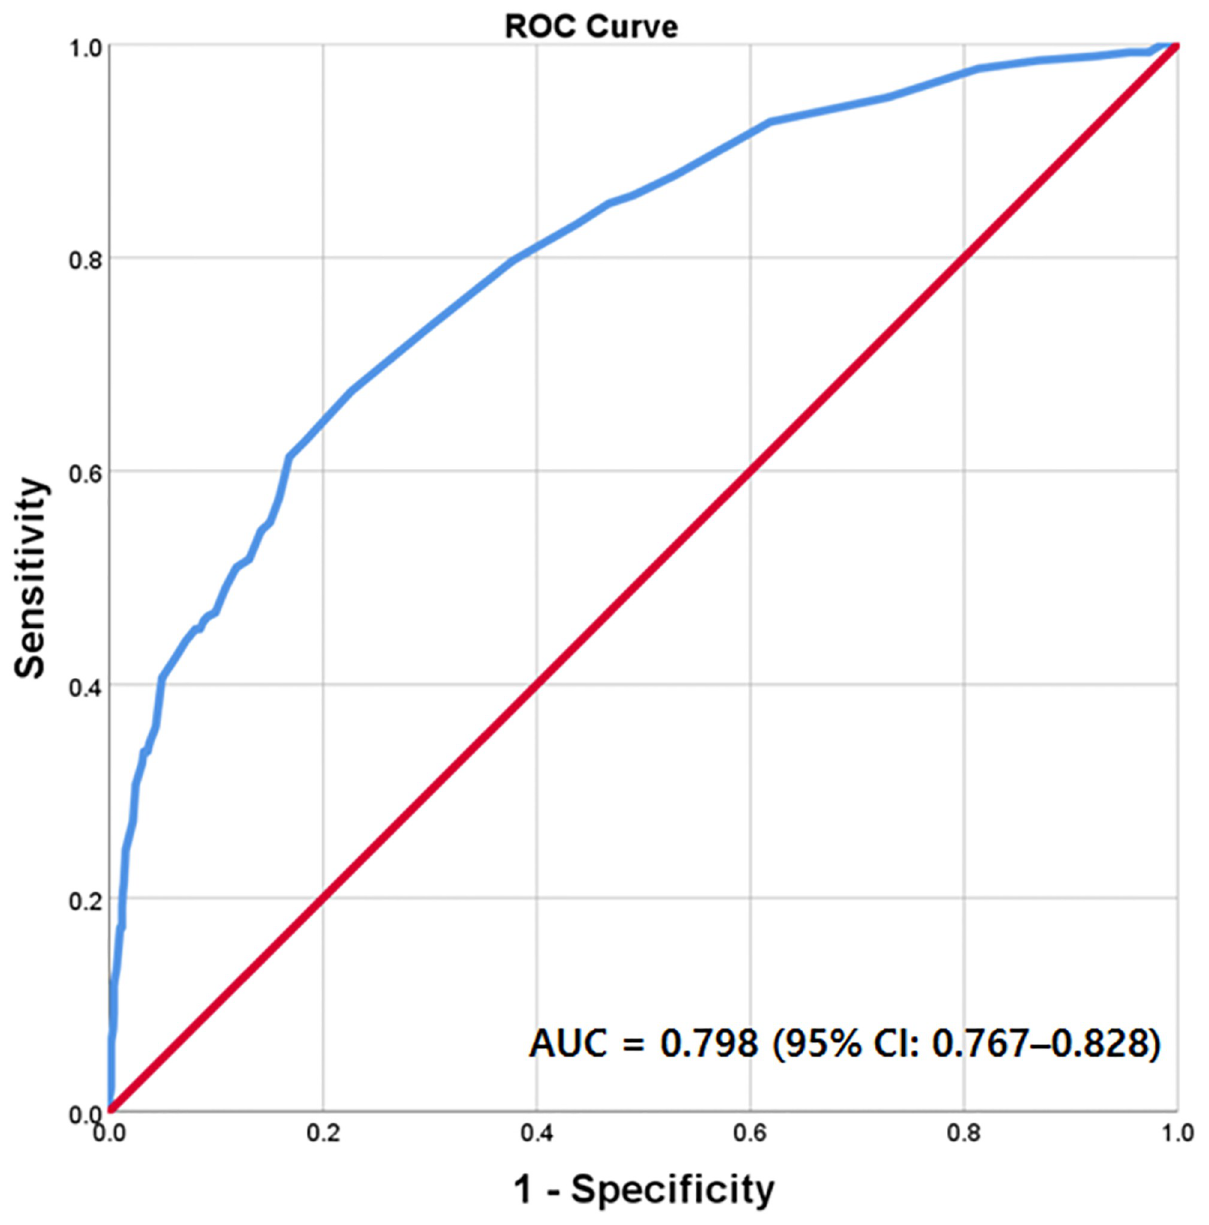
Fig 2. Receiver operating characteristic (ROC) curves of AKI prediction score to predict AKI in patient with acute